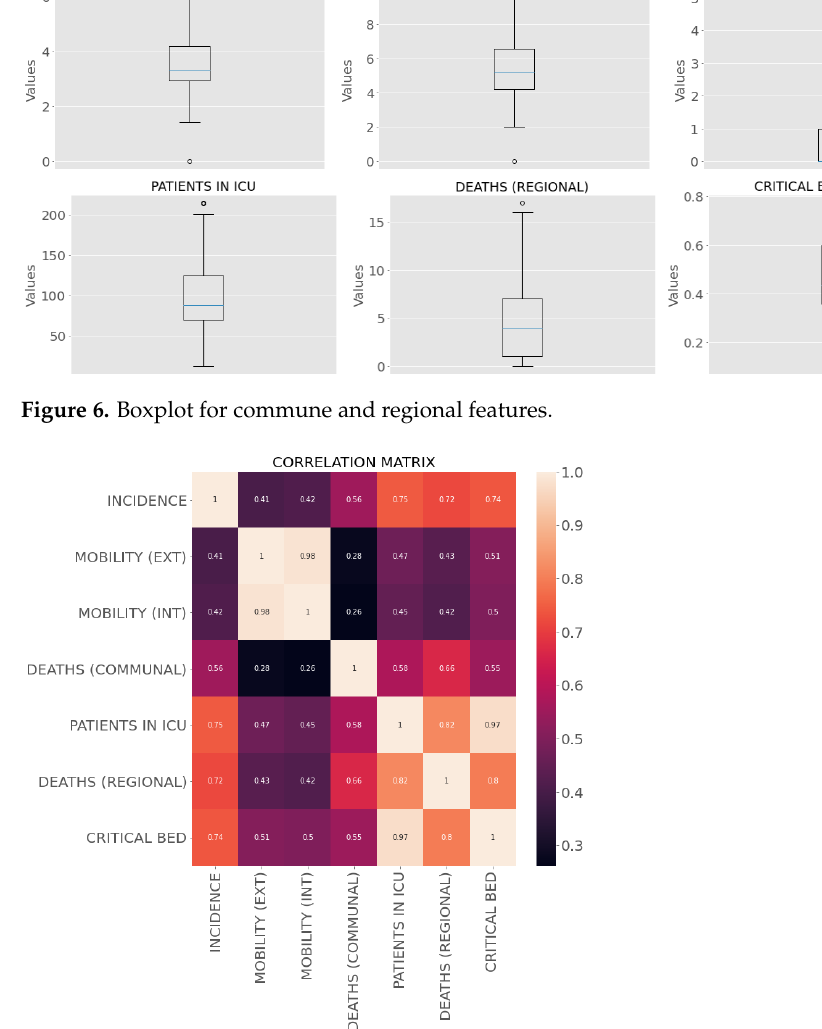
Figure 7. Correlation matrix (pearson) for commune and regional features.